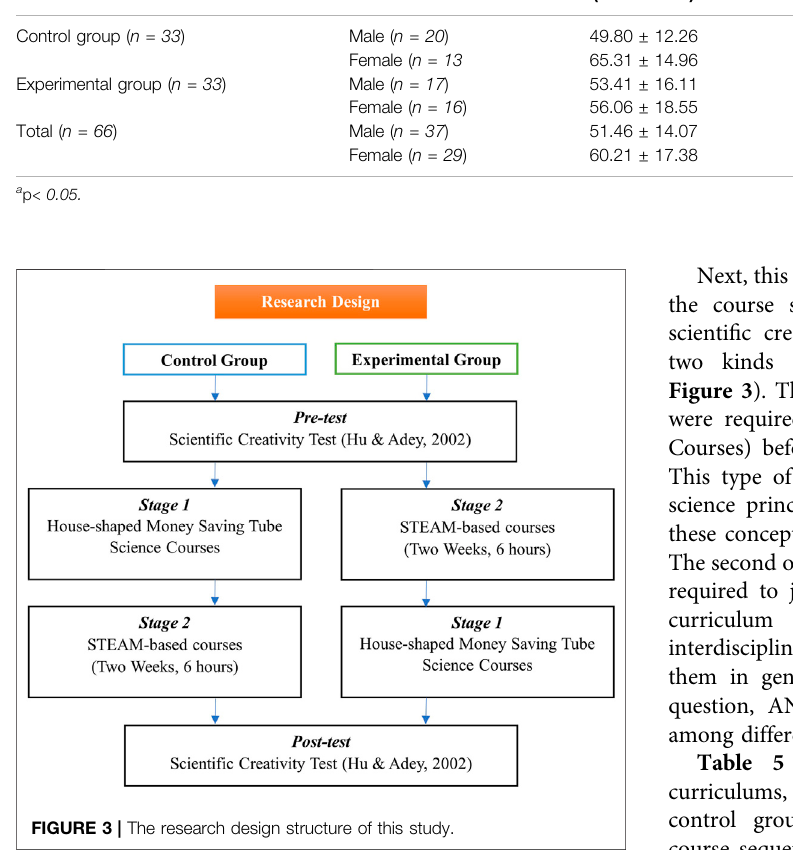
TABLE 7 | The comparison table of pretest and posttest data by gender. Groups